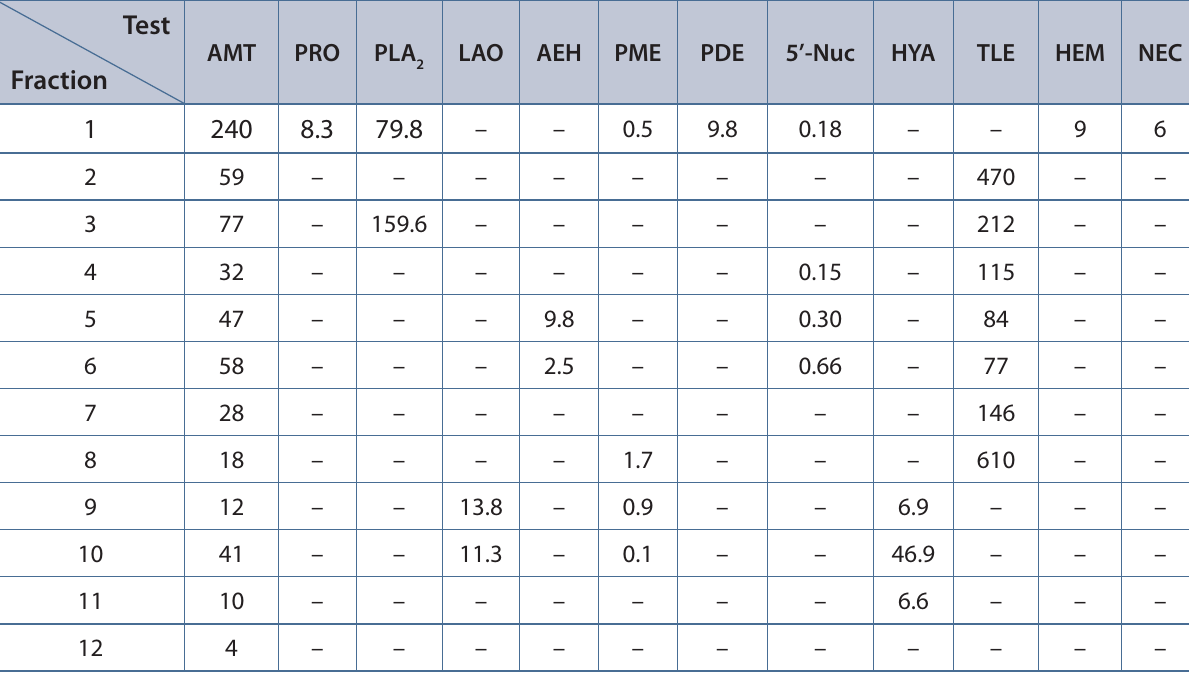
Table 2. Enzymatic, hemorrhagic and necrotic activities of major protein fractions of H. hypnale venom obtained from Resource Q ion-exchange